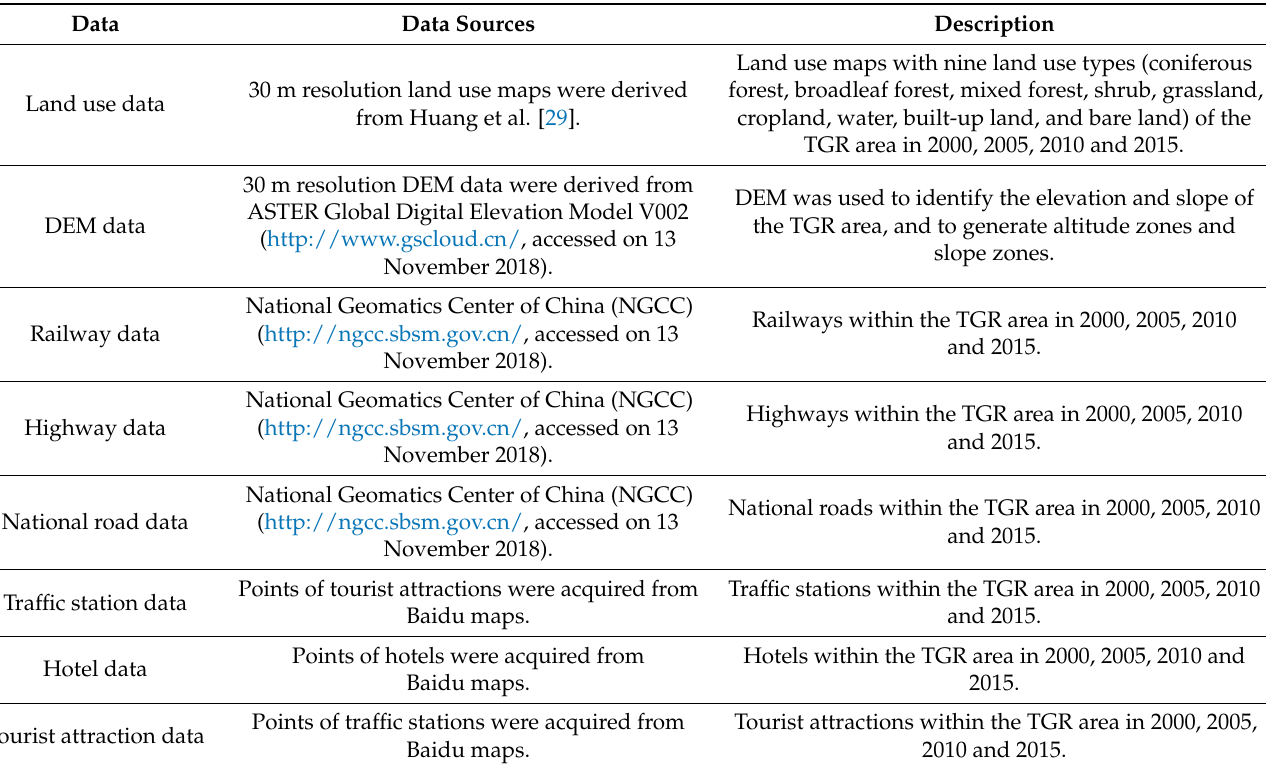
Table 1. The study data and description.